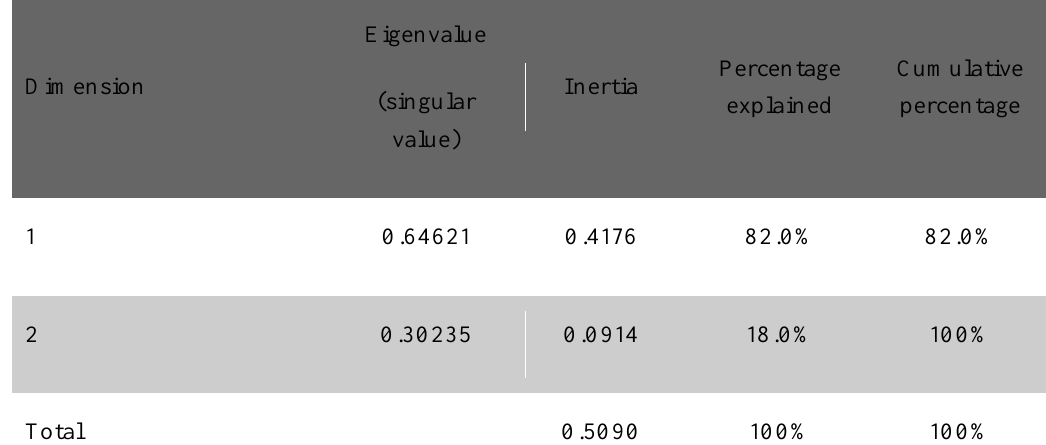
Eigenvalues and Percentage and Cumulative Explained